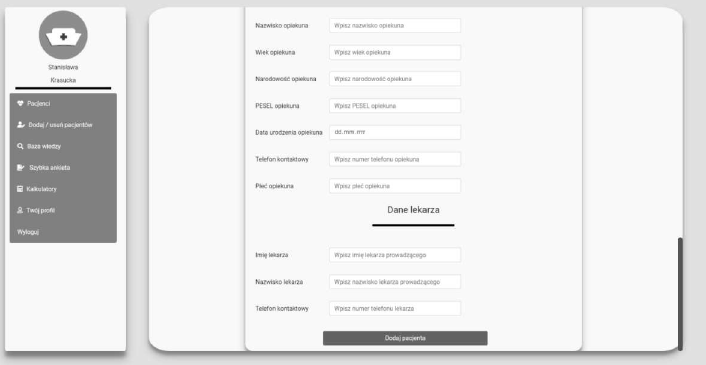
Figure 6. Appearance of the module allowing to add a new patient – part 2